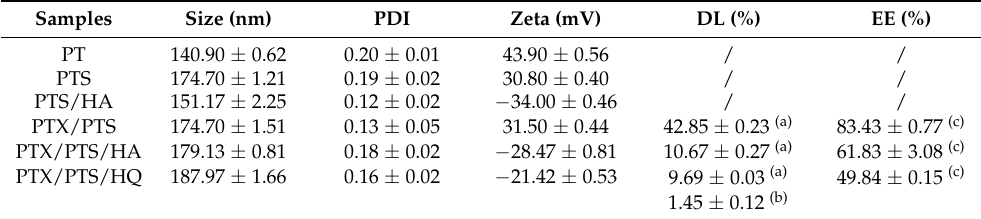
Table 1. Characterization of different PNPs, including particle size, PDI, zeta potential, DL (%), and EE (%). Data are presented as the mean values ± SD ( n =